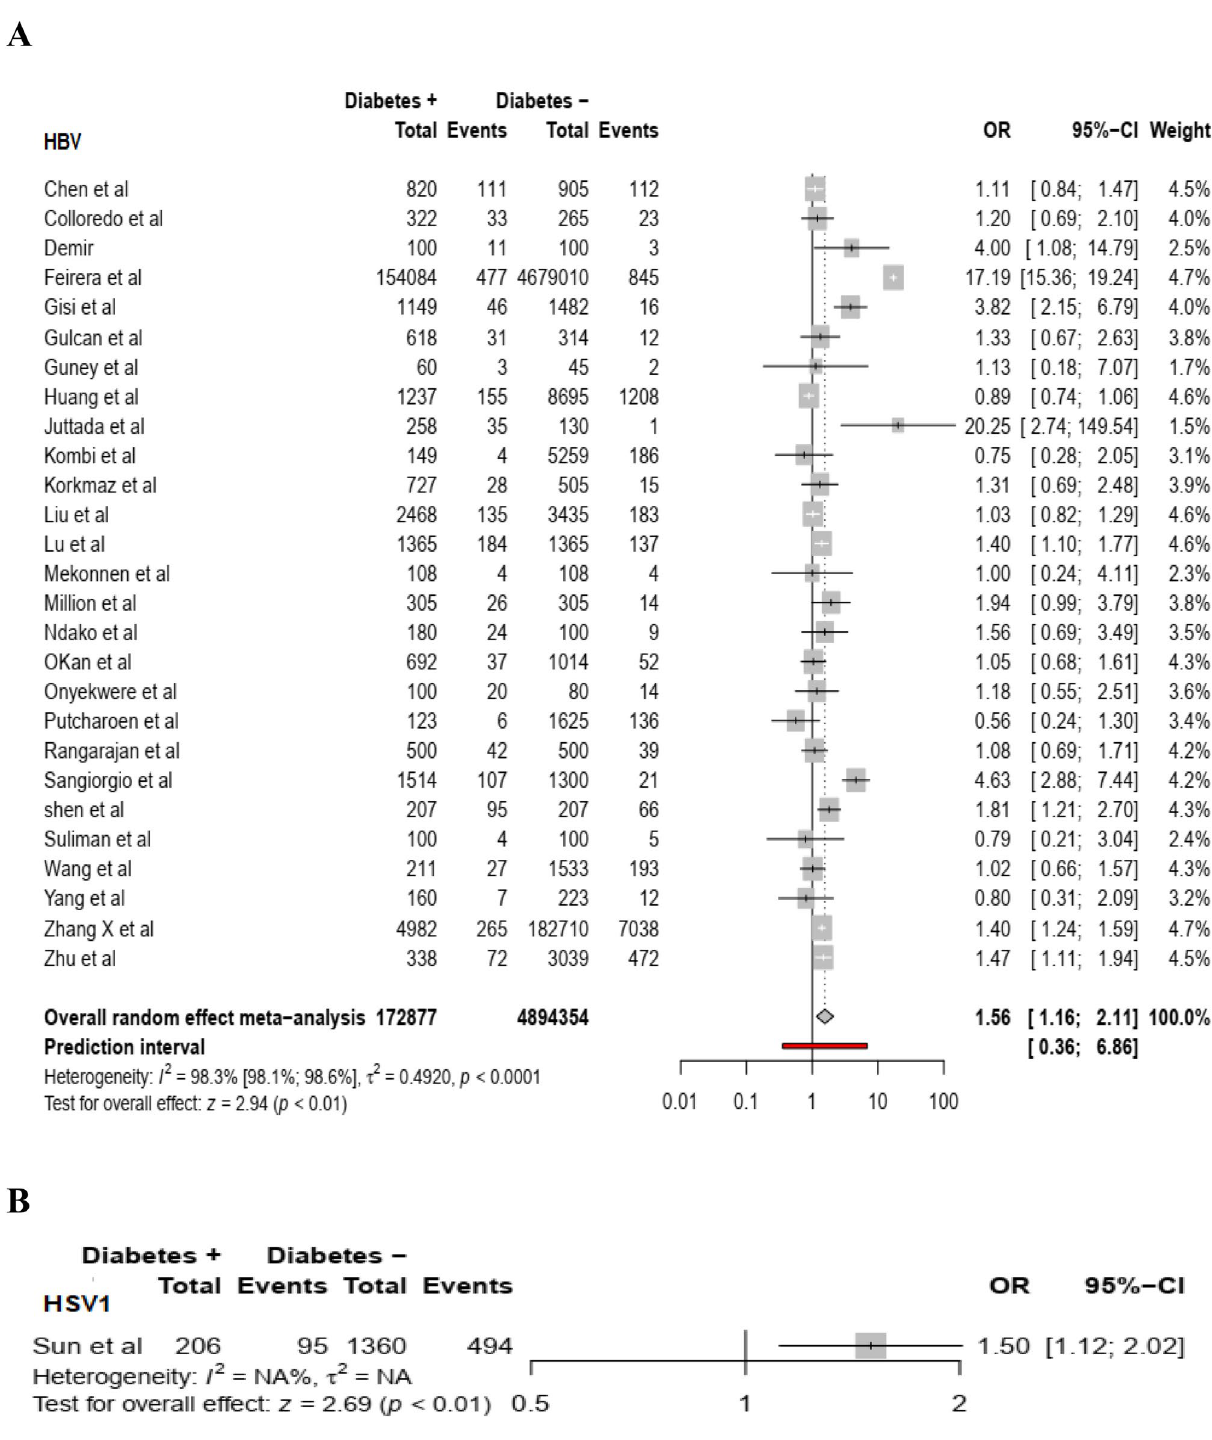
Figure 3. Meta-analysis of the association between HBV ( A ), HSV1 ( B ) and non-autoimmune diabetes